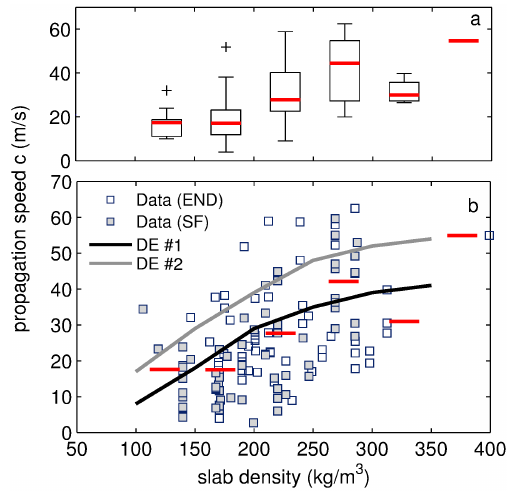
Figure 12. (a) Boxplot of the propagation speed c versus slab den- sity for all field experiments. The data were grouped by slab density classes of 50kgm − 3 . The red line represents the median value, the edges of the box are the 25th and 75th percentiles, the whiskers extend to the most extreme data points without considering the out- liers, and outliers are plotted individually as a cross. (b) Crack prop- agation speed c vs. slab density ρ . The open squares correspond to field PSTs with full propagation (END) and the solid squares corre- spond to PSTs with fracture arrest (SF). The black line corresponds to the result of the DE model taking into account the relation be- tween slab density, Young’s modulus for a slope angle ψ = 0 ◦ and a slab thickness D = 20cm (case #1). The gray continuous line cor- responds to the result of the DE model taking into account the re- lation between slab density, Young’s modulus and thickness for a slope angle ψ = 23 ◦ (case #2). The red lines represent the median values of the density classes (same as in a ). The data consist of N = 121 PST